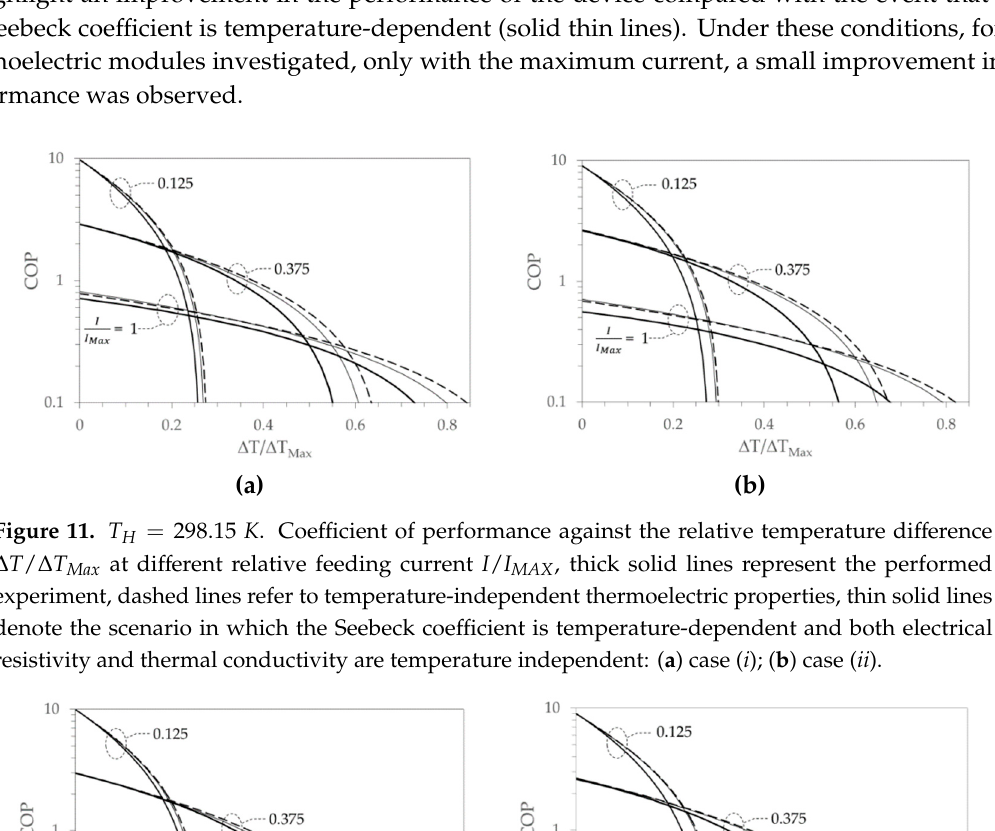
maximum current, a small improvement in the performance was observed.